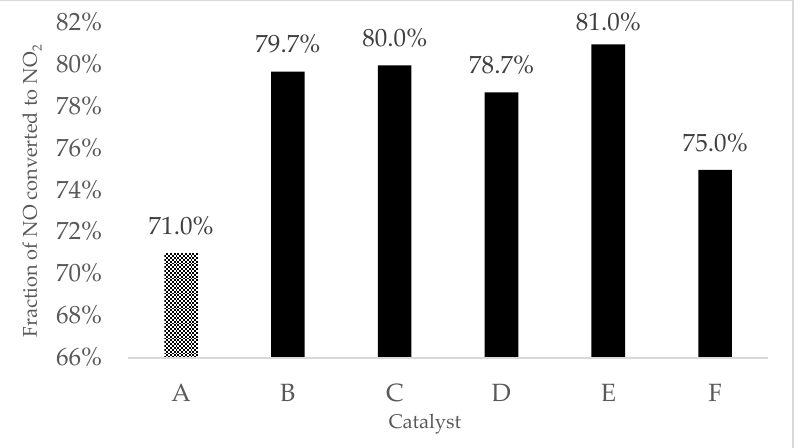
Figure 9. Catalytic performance for NO oxidation to NO 2 at 200 °C: (A) 9MnO 2 – 1CeO 2 , (B) Co/9MnO 2 – 1CeO 2 , (C) Ni/9MnO 2 – 1CeO 2 , (D) Fe/9MnO 2 – 1CeO 2 , (E) Cu/9MnO 2 – 1CeO 2 , and (F) Cr/9MnO 2 – 1CeO 2 .